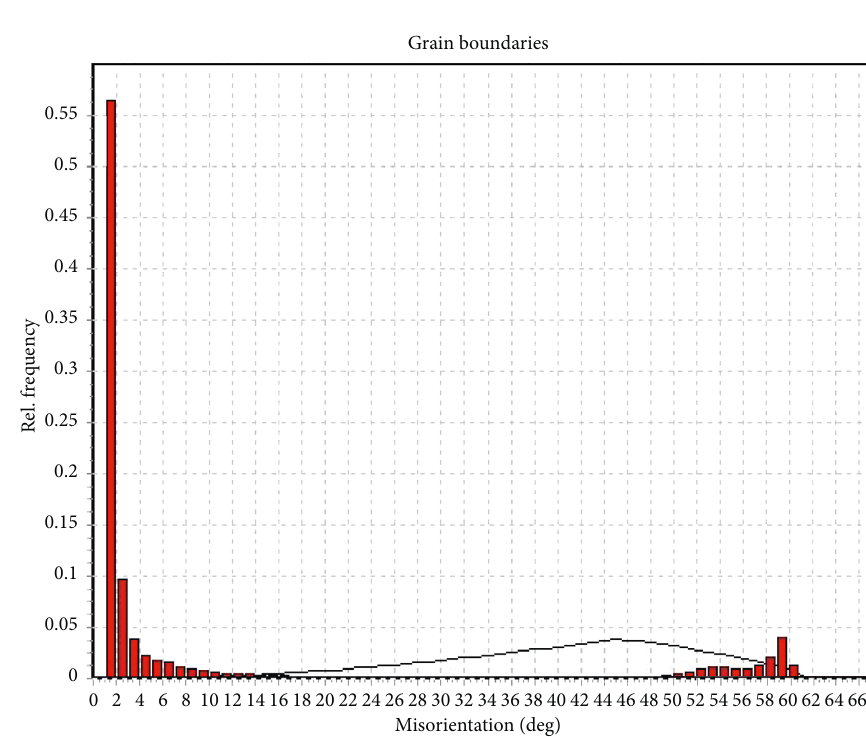
Figure 17: Grain boundary misorientation distribution histogram of